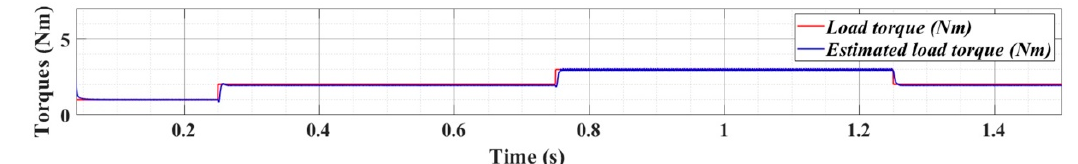
Figure 14. Block diagram of the estimation of the load torque T L .